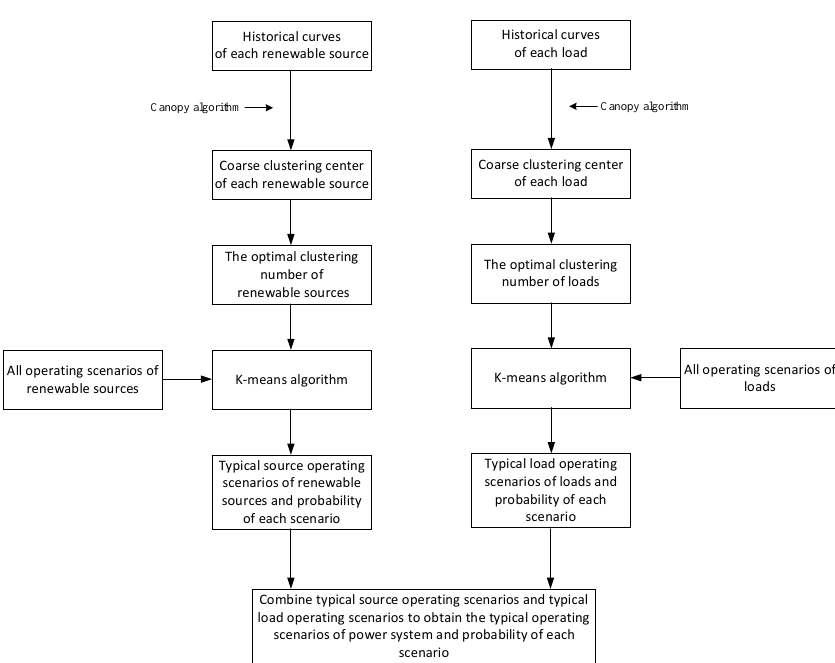
Figure 3. Flowchart of typical operating scenarios generation method.